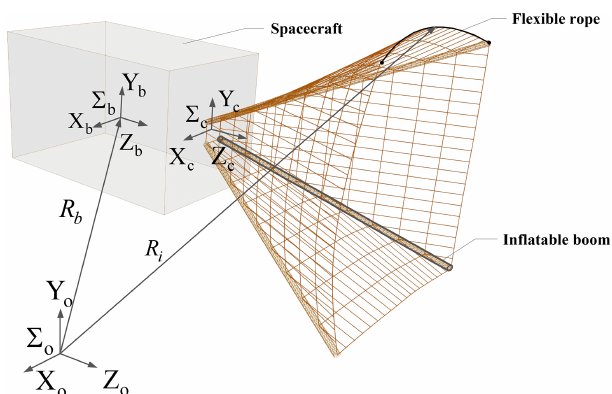
Figure 2. Reference coordinate systems of